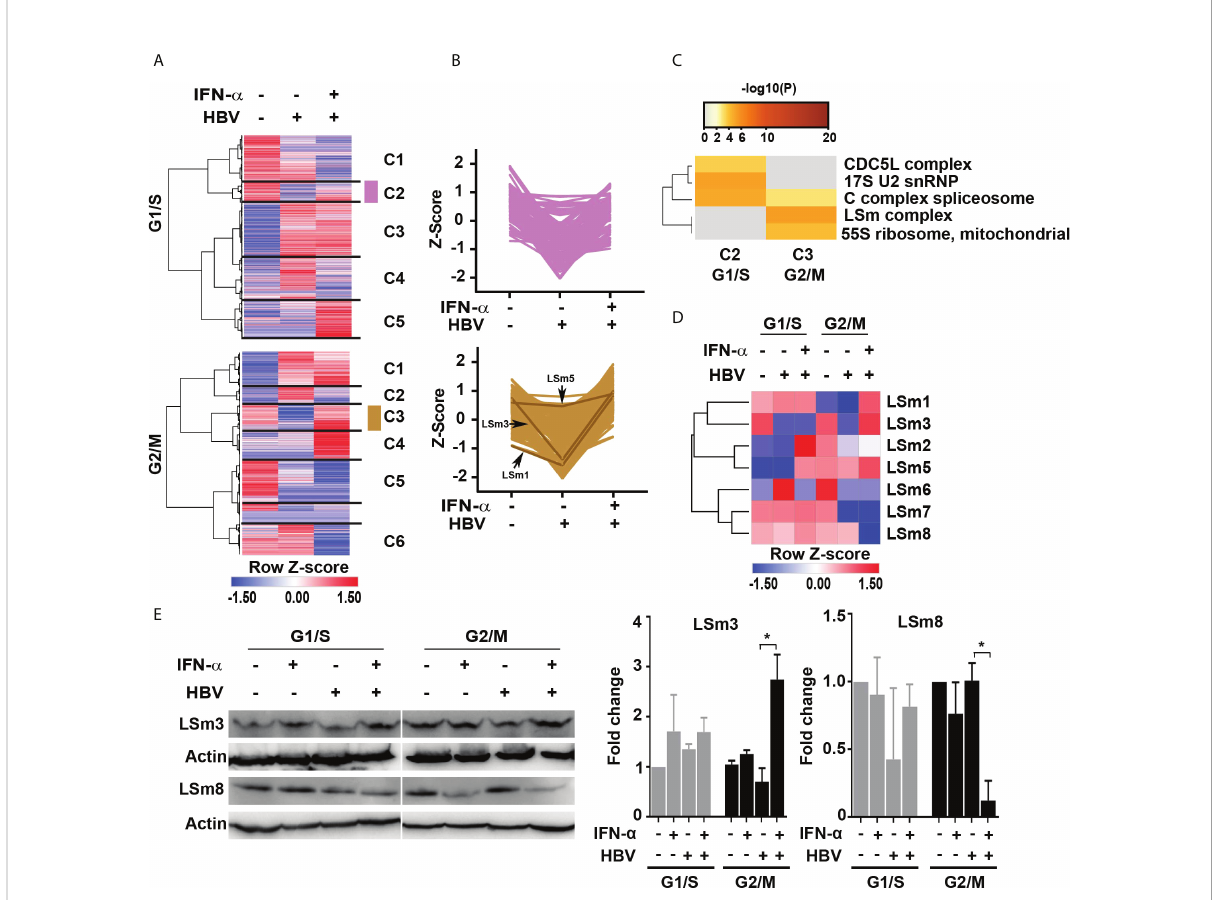
FIGURE 2 IFN- a regulated proteins in HBV replicating hepatocytes as a function of cell cycle progression. (A) Hierarchical clustering of signi fi cantly changed proteins as a function of HBV replication and IFN- a treatment in hepatocytes synchronized in G1/S and G2/M phases analyzed by one way ANOVA (p <0.05). (B) The changes in protein abundance (relative intensity value) of cluster C2 (112 proteins) of G1/S and C3 (157 proteins) of G2/M were normalized to Z score, using the Perseus platform (29). In G2/M C3, protein intensity of the LSm1, 3 and 5 subunits is shown. (C) Comparison of protein complex enrichment analyses of G1/S cluster C2 proteins and G2/M cluster C3 by the CORUM database. (D) Heatmap representation of LSm1-8 expression as a function of HBV replication and IFN- a treatment in hepatocytes synchronized in G1/S and G2/M phases. Color scale represents label free quanti fi cation (LFQ) Z-scored values. (E) Immunoblots of LSm3 and LSm8, using cell lysates from G1/S and G2/M synchronized HepAD38 cells, +/- HBV replication for 4 days and IFN- a (500 ng/ml) treatment, as indicated. A representative immunoblot is shown; (Right panels) quanti fi cation of LSm3 and LSm8 vs. actin, using unpaired t-test.